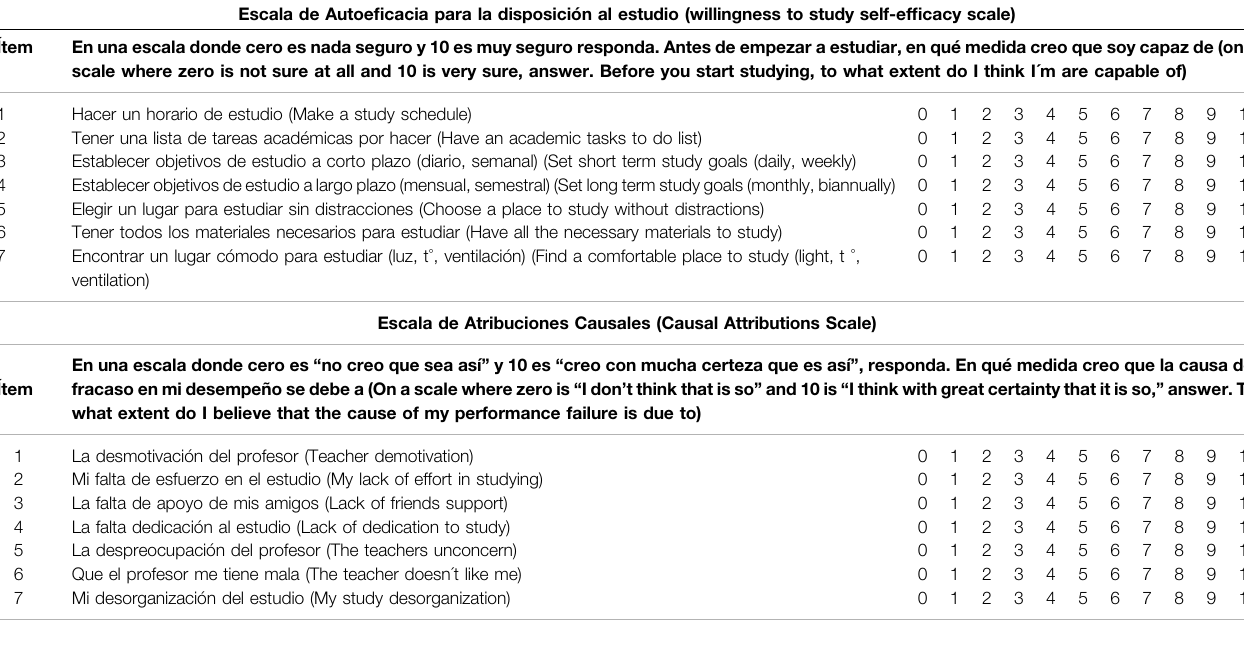
TABLE 3 | Scales to assess self-regulation of learning phases with Likert scales 0 – 10.